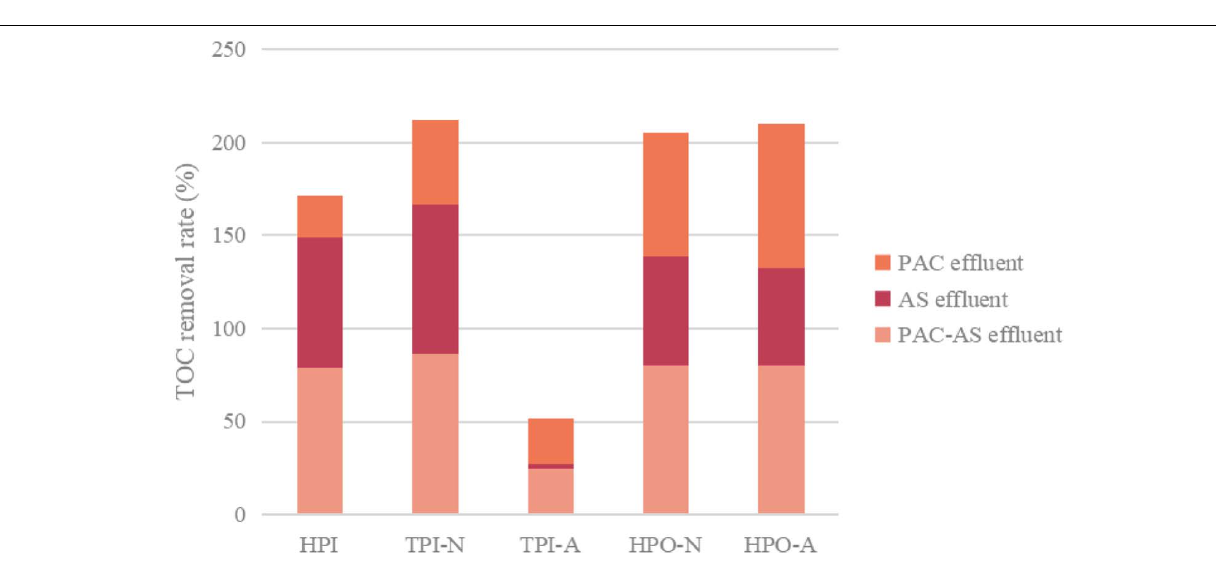
FIGURE 8 | Changes of hydrophilicity and hydrophobicity of organic matter before and after waste water